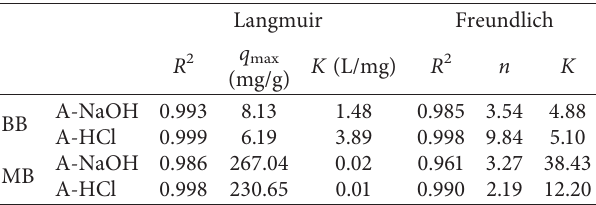
Table 3: Parameters relating to Langmuir and Freundlich isotherm equations.